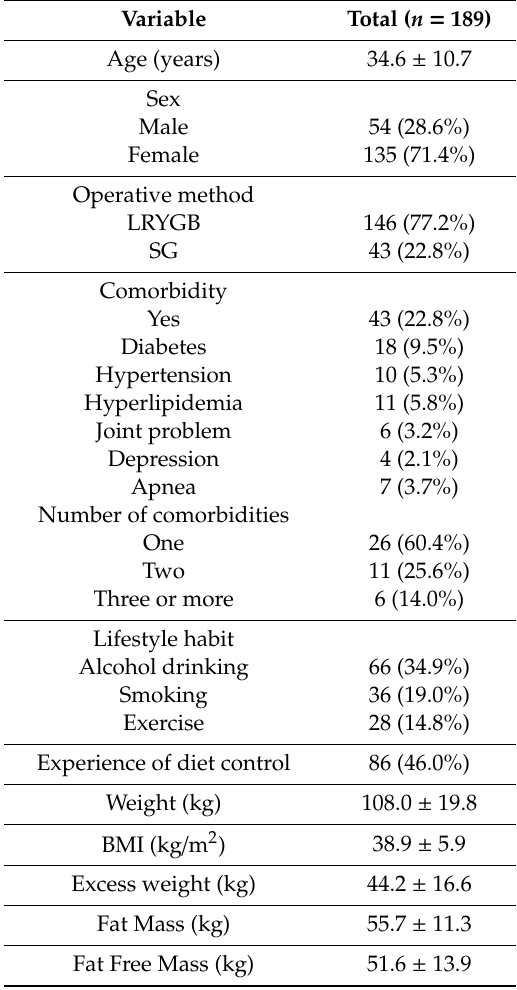
Table 1. Baseline characteristics in all